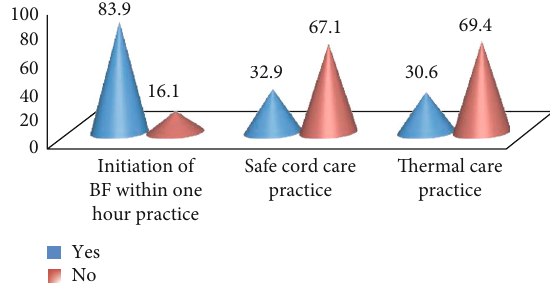
Figure 2: Identi fi ed three composite newborn care practices separately by mothers with babies of one-month-old after delivery in the community of Hossana town, southwest Ethiopia,